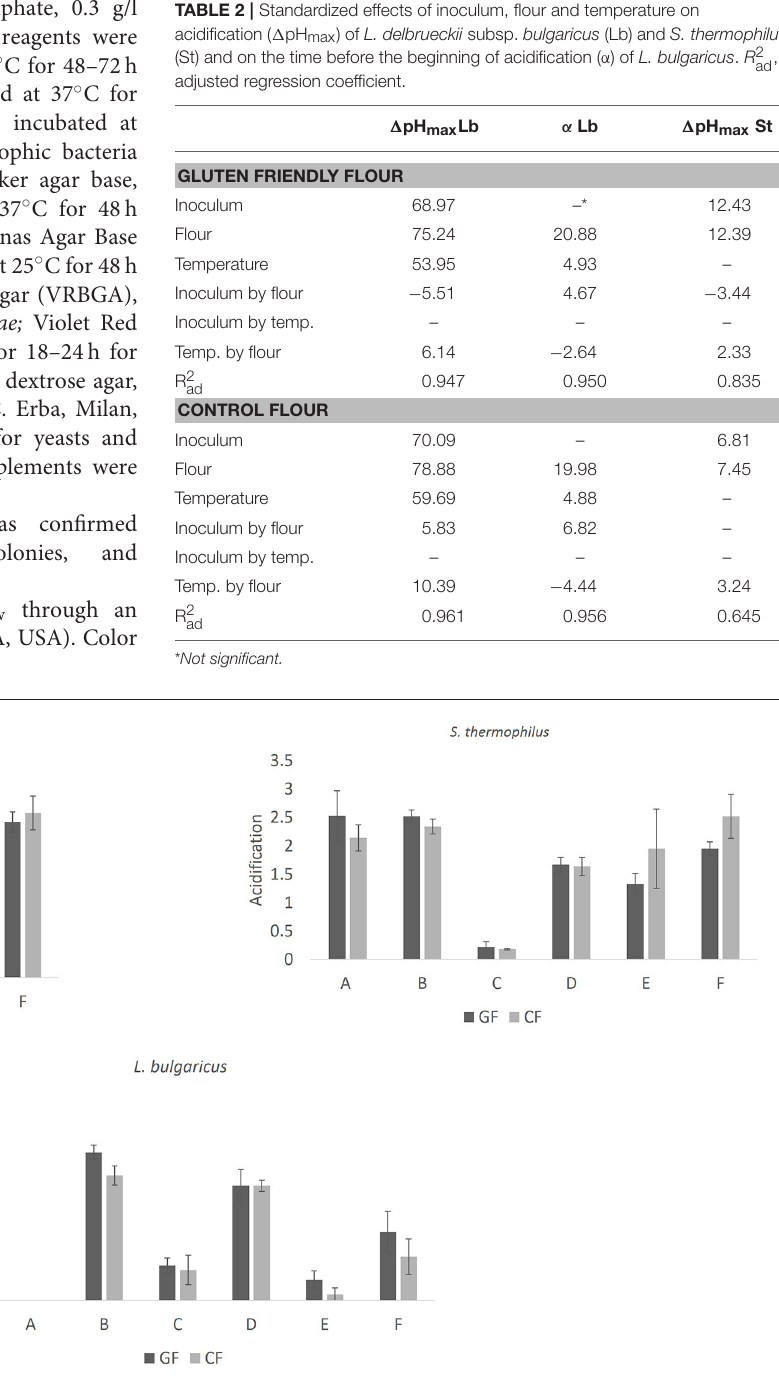
Frontiers in Microbiology |